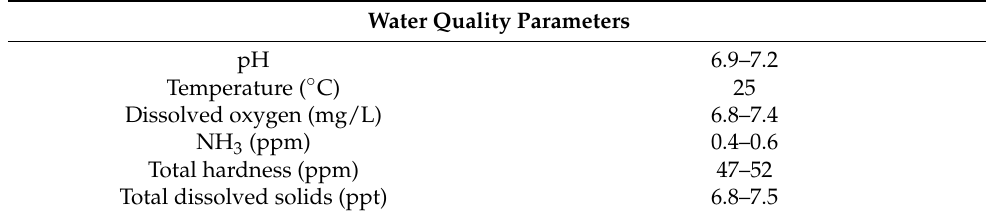
Table 1. Water quality parameters maintained during the acclimatization